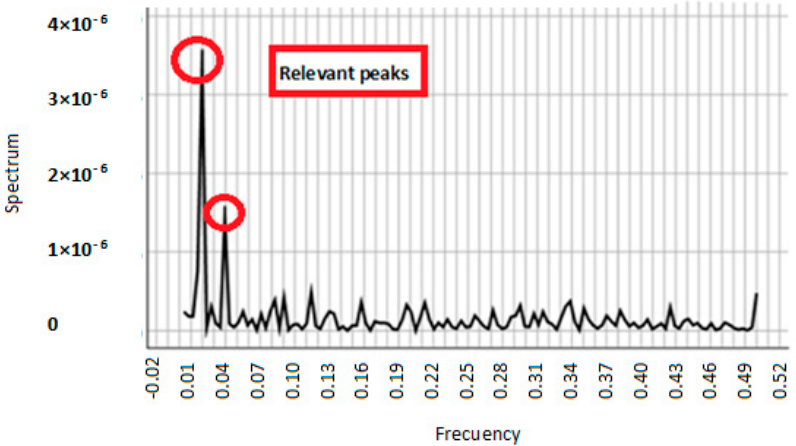
Figure 6. Periodogram of weekly beta activity concentrations over the period 2014–2018 in Bilbao.